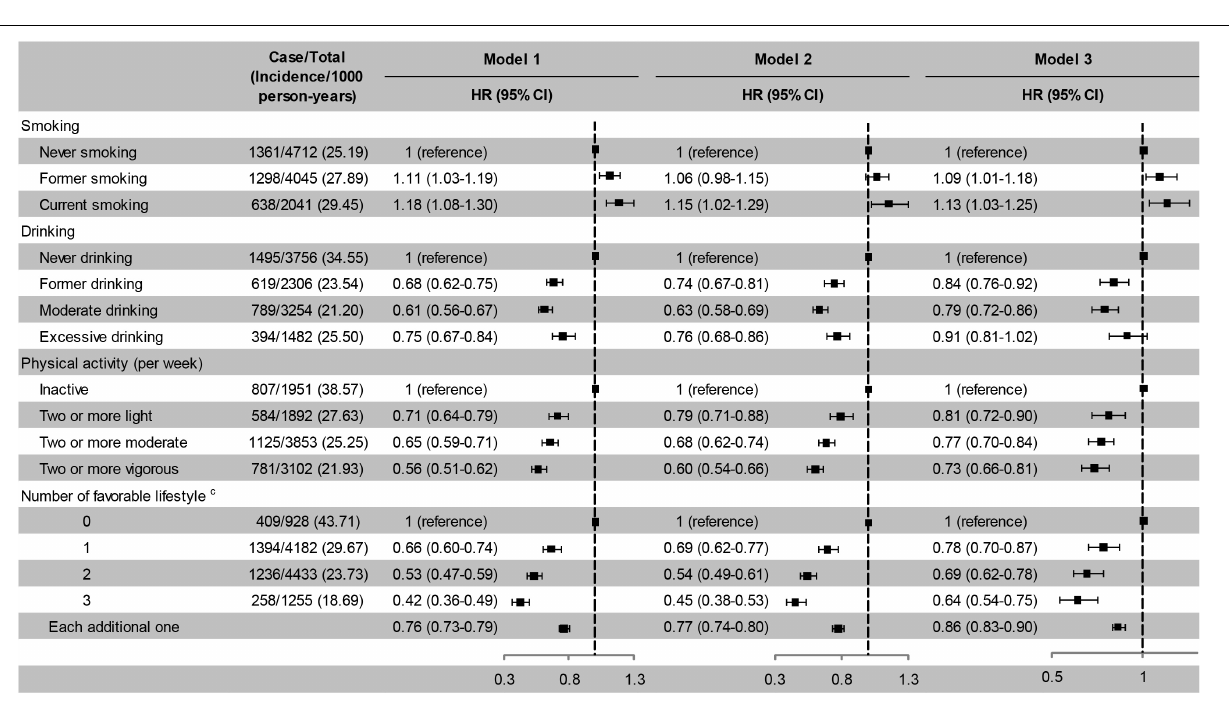
FIGURE 3 | Risk of cognitive impairment according to lifestyle. Model 1, unadjusted; Model 2, adjusted for baseline age and sex; Model 3, adjusted for baseline age, sex, education, marital status, family wealth per capita, lifestyle, body weight status, and PRS for BMI. c Moderate drinking was considered favourable. HR, hazard ratio; CI, confidence interval. The significance level was set at α =